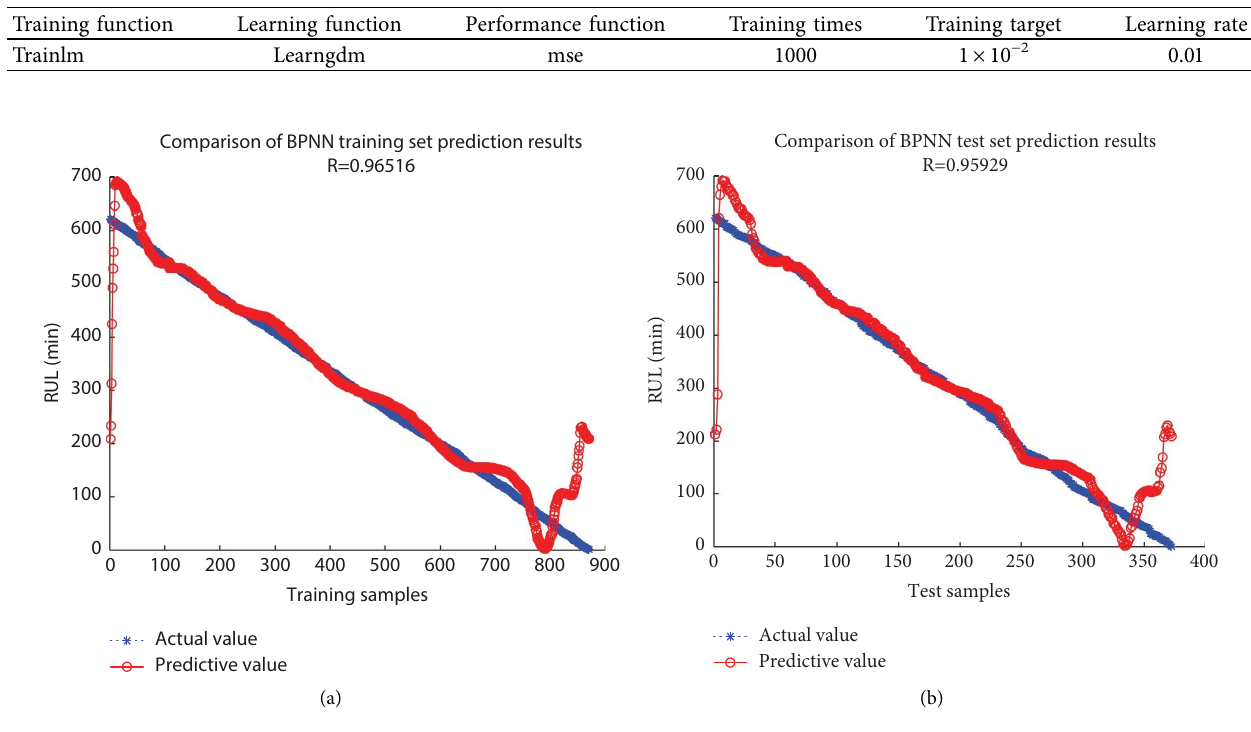
Table 5: Network model training